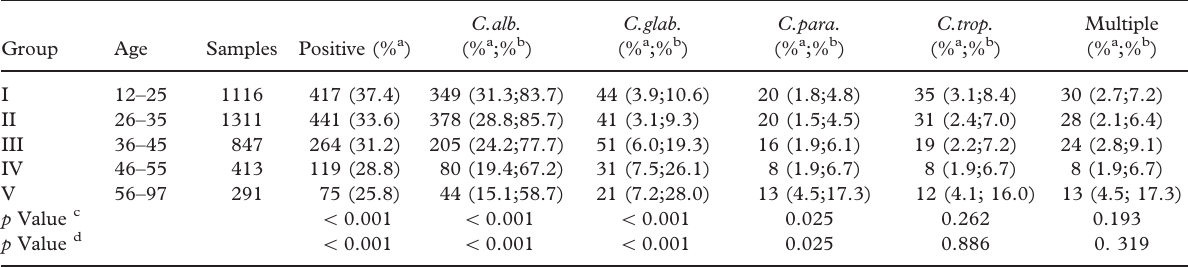
Table II Distribution of samples and detection of Candida species by subjects’ age in